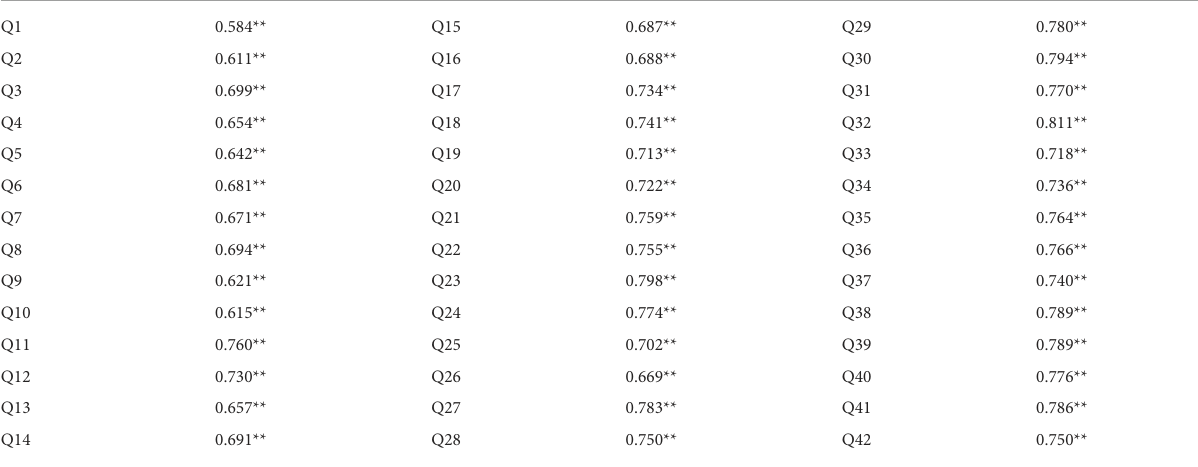
TABLE 3 Pearson correlation coefficient table.